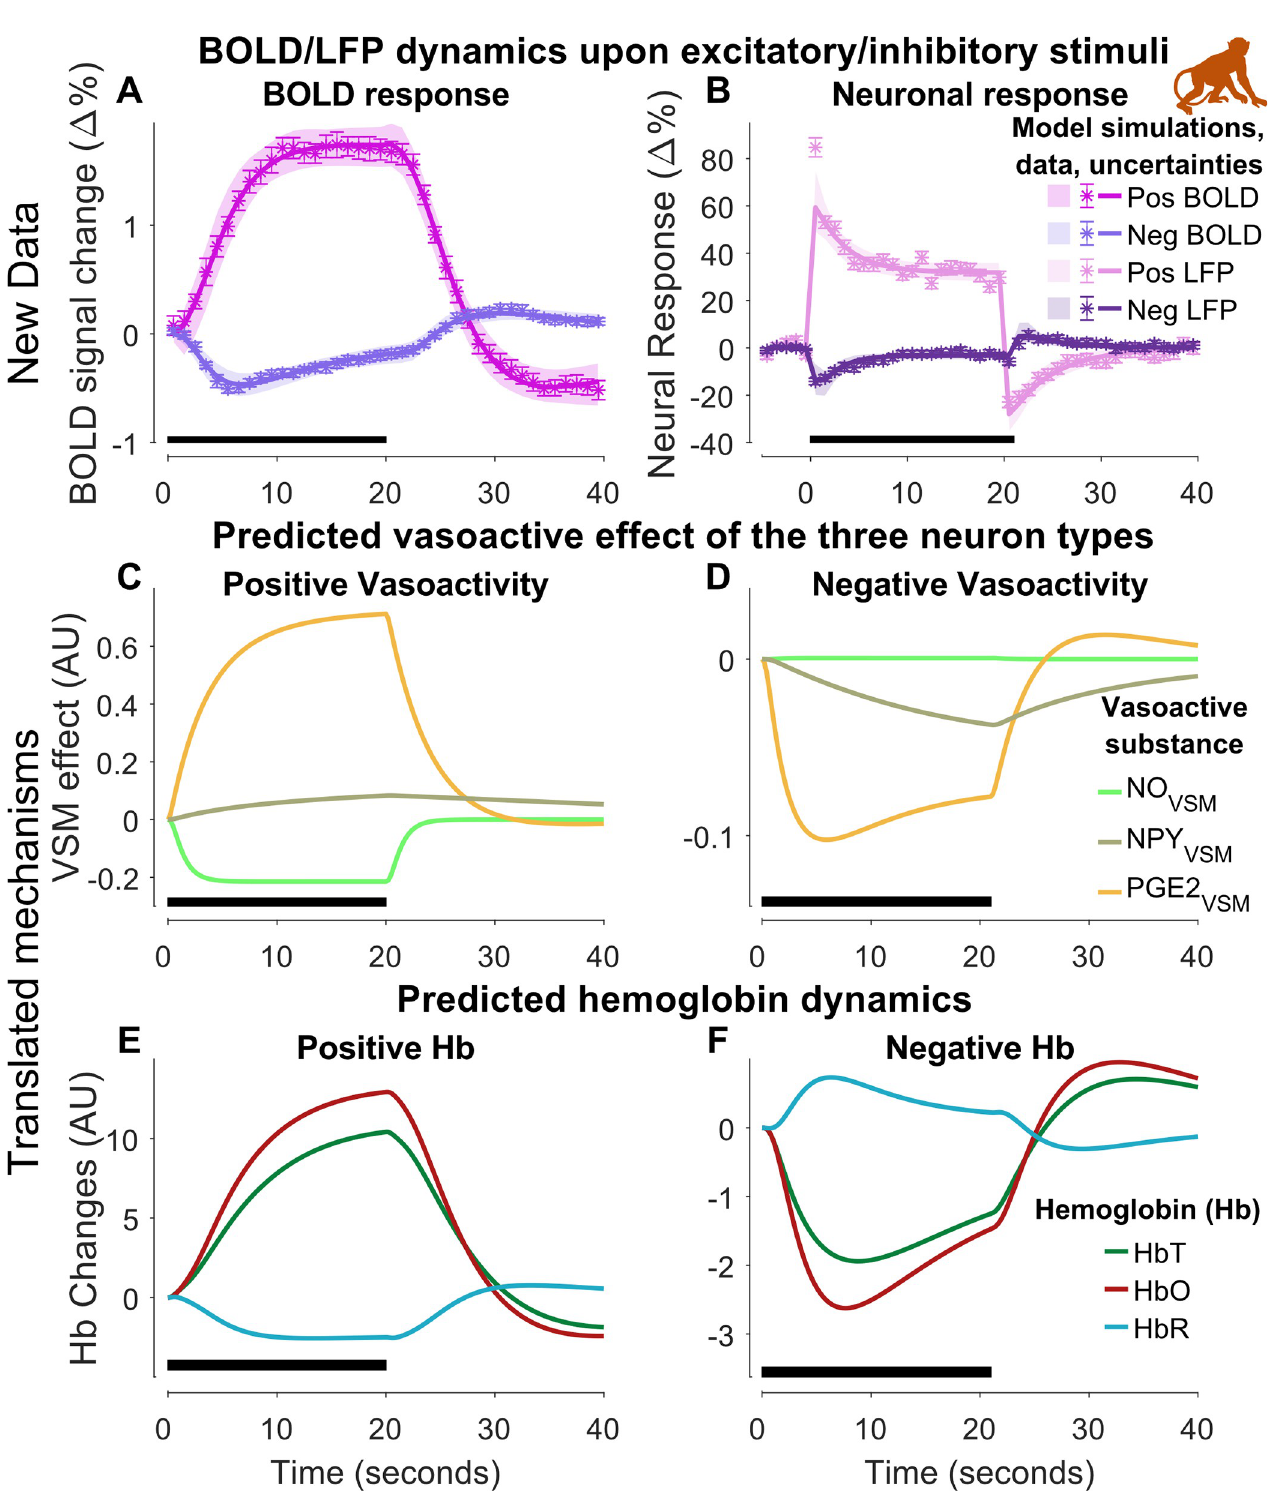
Fig 6. Model estimation to experimental data from macaque primates (Section 2.2). We see blood oxygen level dependent (BOLD) (A) and electrophysiological (B) responses in macaques for two variants of a visual task. The visual task was 20 s long, for the positive task, and 21 s, for the negative task, visual stimulation of V1 in the visual cortex (marked with the black bar in the bottom left portion of each graph). In A & B: experimental data (colored “ � ”-symbols); the uncertainty of the experimental data is presented as the standard error of the mean (SEM) (colored error bars); the best model simulation is seen as colored solid lines corresponding to respective measurement observables. The model uncertainty is seen as the semi-transparent colored areas. The x-